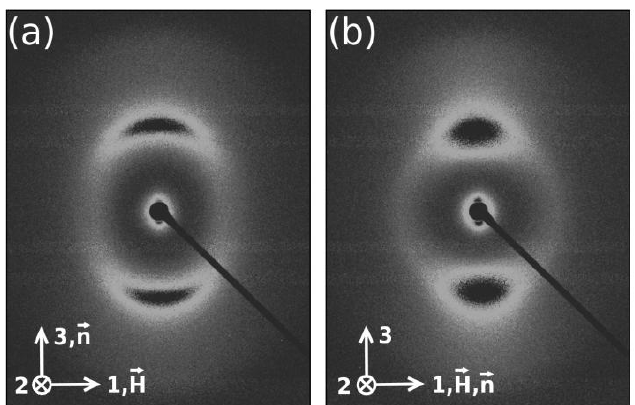
O: ( a ) N phase, T = 36.0 °C; ( b ) N 2 D